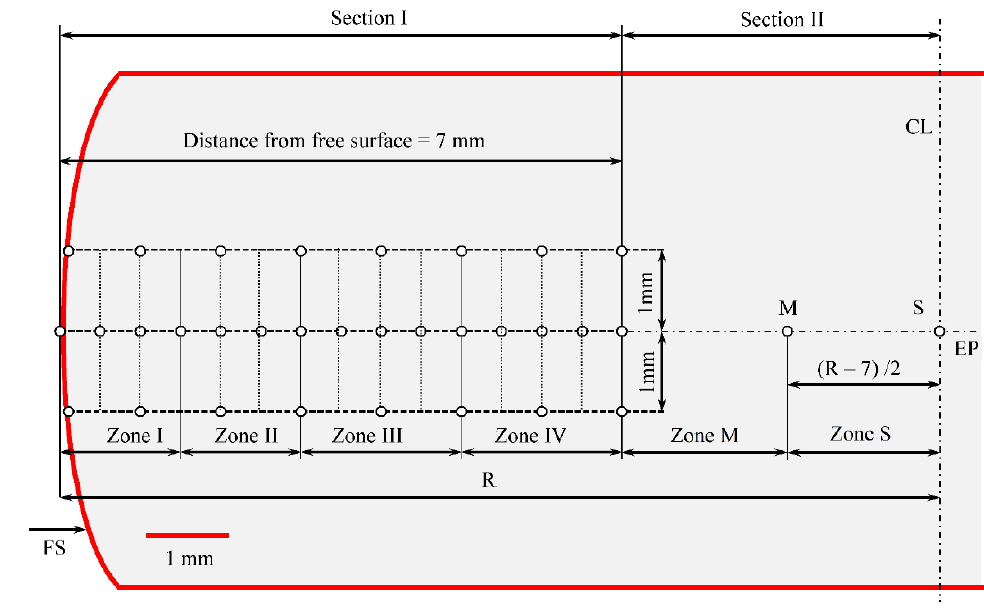
Figure 2. Locations of the testing points (longitudinal cross section) (o—SEM testing points; FS—free surface; EP—equatorial plane; CL—center line; R—equatorial radius).